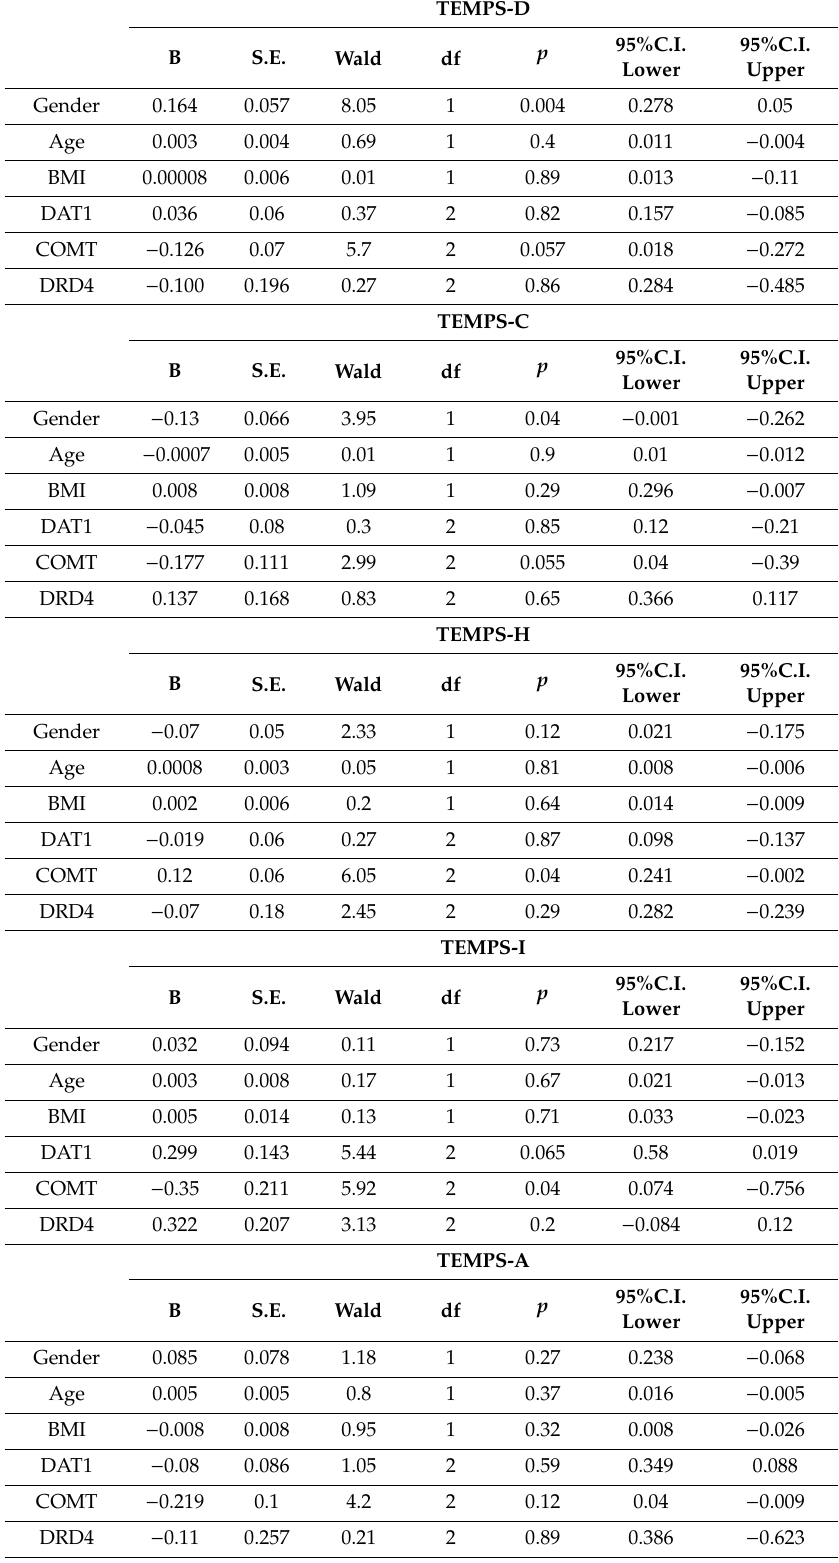
Table 7. Logistic regression model coe ffi cients on TEMPS-A temperaments